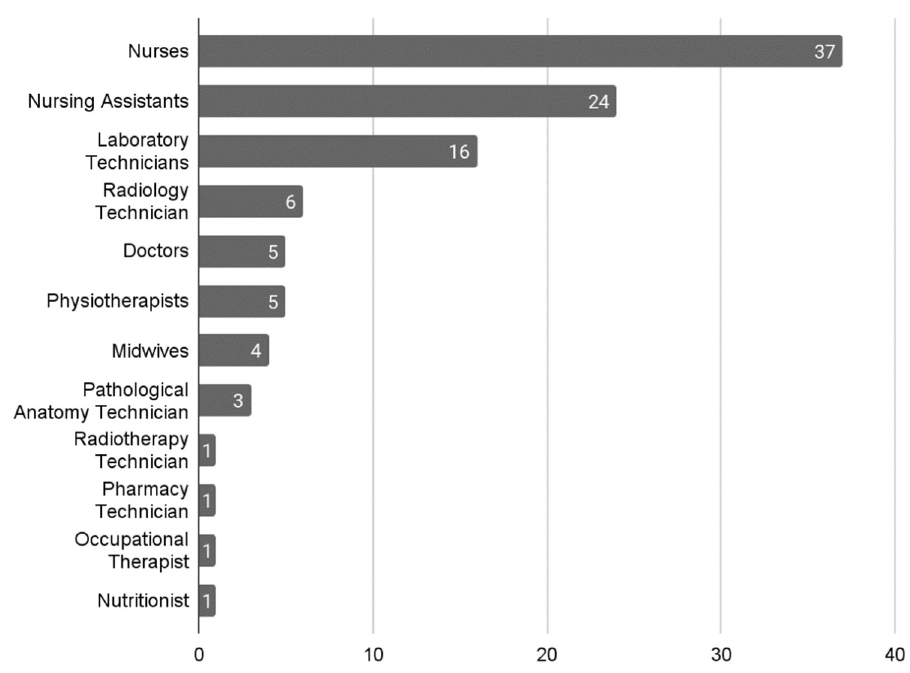
Figure 2. Distribution according to professional profiles. Table 1. Hours of training by age